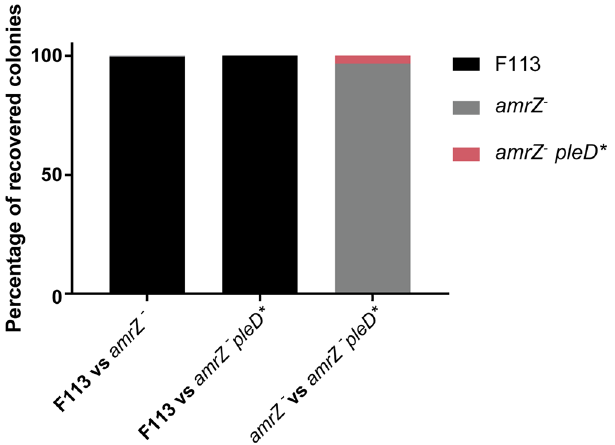
Figure 5. c-di-GMP does not restore the defective rhizosphere competitive colonization phenotype of an amrZ mutant. Pseudomonas ogarae F113 wild-type, amrZ - , and the amrZ mutant containing a miniTn7-based pleD* integration were tested in competitive colonization assays. CFUs recovered from the alfalfa rhizosphere after seven days post-inoculation were tested for antibiotic resistance to distinguish the different strains. Percentages of colonies are represented. Each experiment was repeated twice with ten plants per